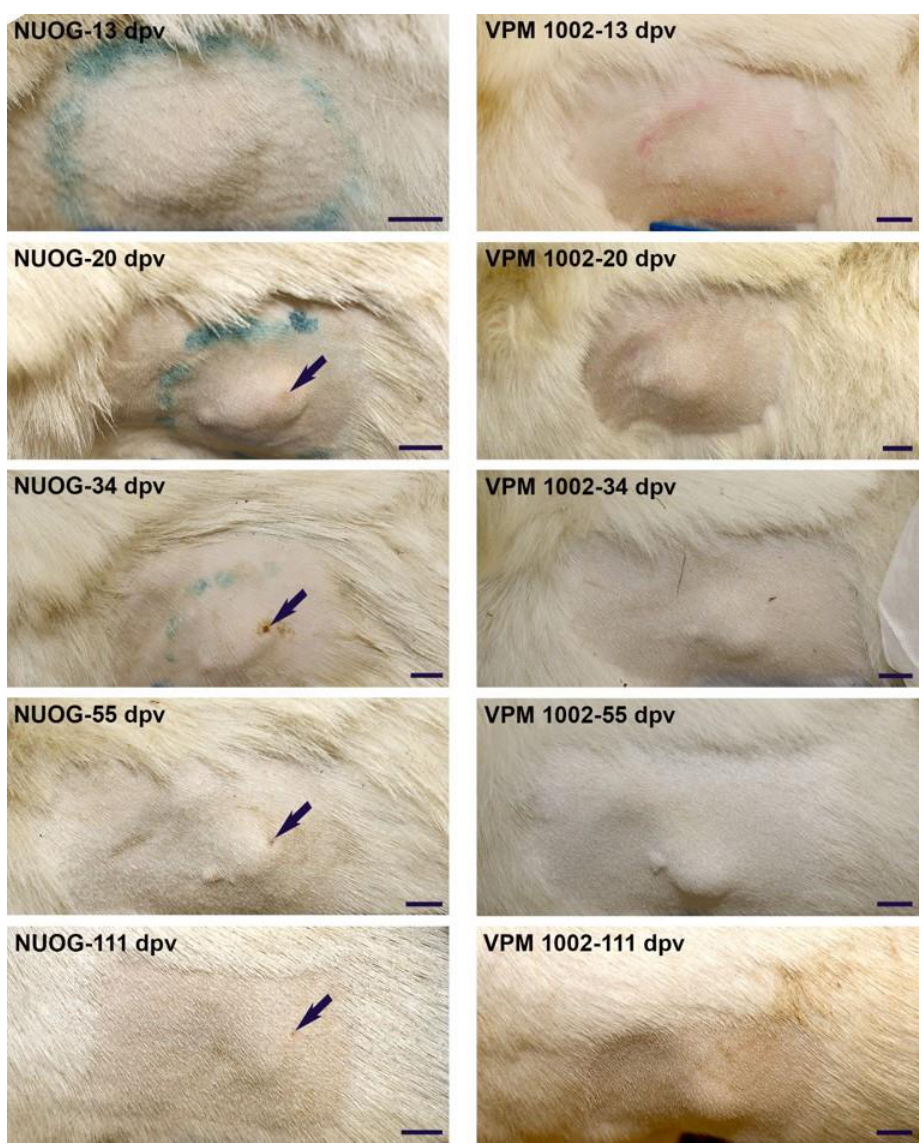
Figure 3. Representative photographs showing the development of skin lesions at the injection site from 13 to 111 days post vaccination (dpv). Pictured is a nodule with a superficial ulceration (arrow) of an NUOG-vaccinated goat ( left ) and a lesion covered by intact skin of a VPM1002-vaccinated goat ( right ). Size bar: 2 cm. Table 1. Skin lesions at the injection site of goats vaccinated with vaccine strains BCG, VPM1002, NUOG, PDX, or mock-treated . Mean (minimum; maximum) values of a total score per animal group ( n = 6) are indicated. The total score describes the sum of the values for the size of lesion, redness, pain, swelling, local temperature, and necrosis (0 = no reaction, 1 – 4 = mild symptoms, 4 – 8 = moder- ate symptoms).